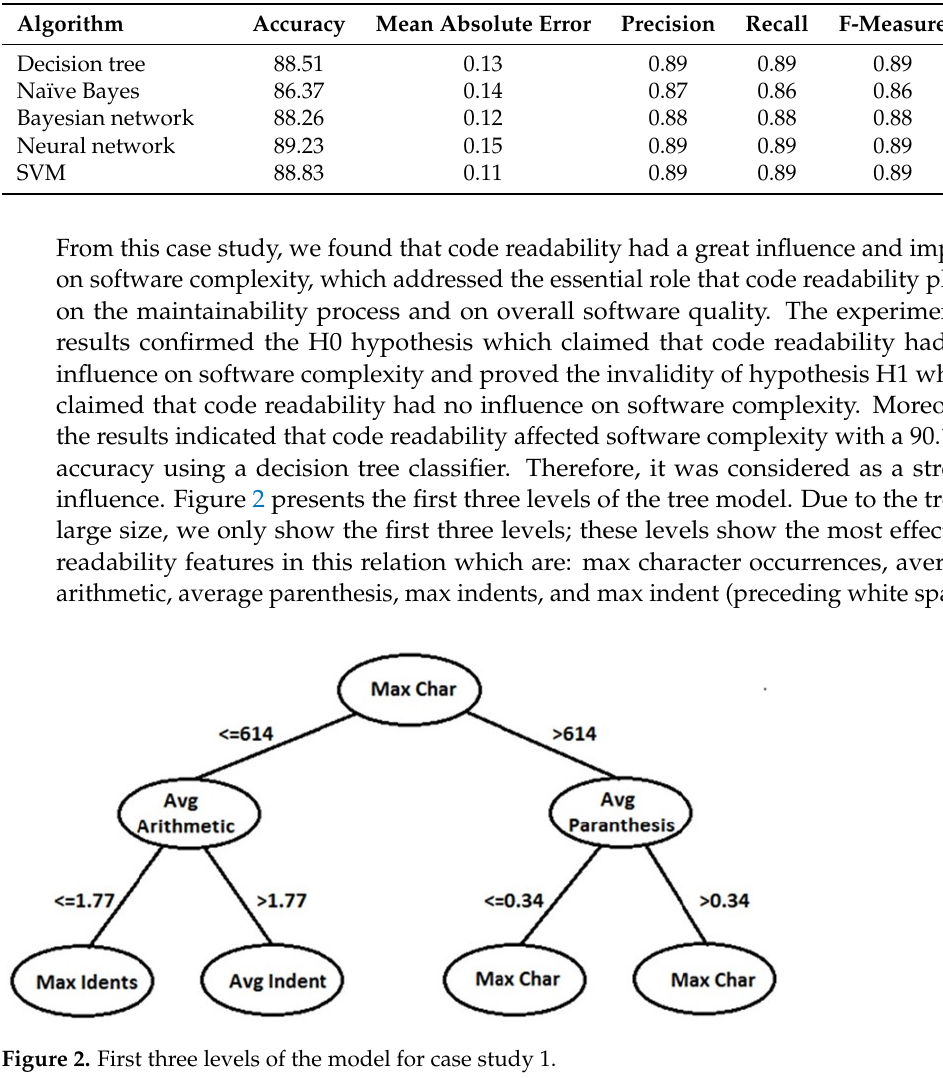
Table 6. Case study 1 results for PCA dimension reduction approach using cross validation.